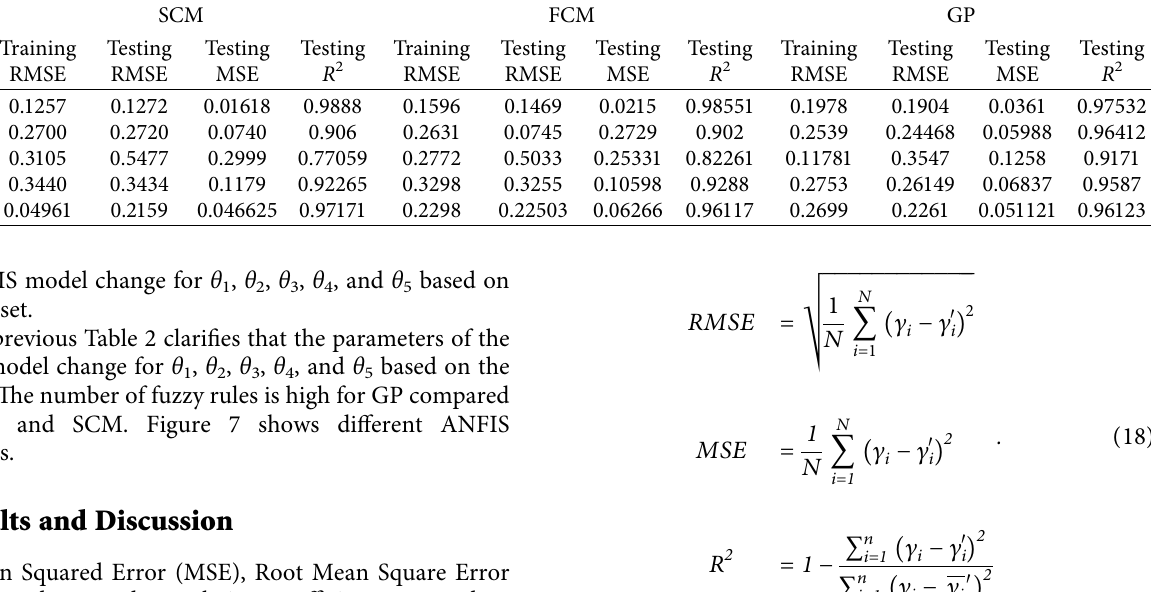
rad, MSE (cid:31) (cid:31)